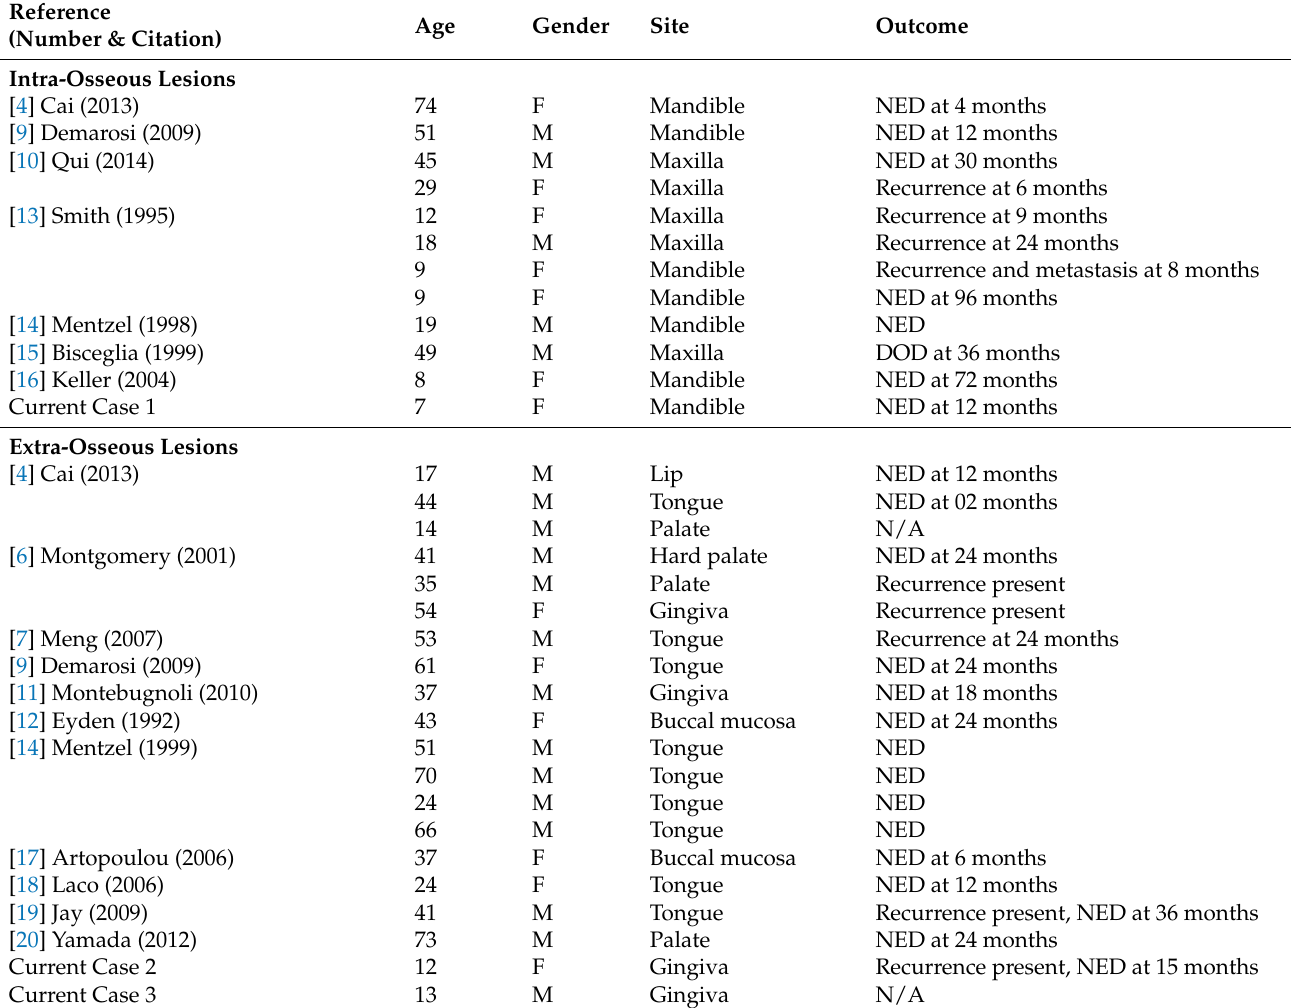
Table 2. Clinical features of low-grade myofibroblastic sarcomas of the oral cavity obtained from the literature and the three new cases